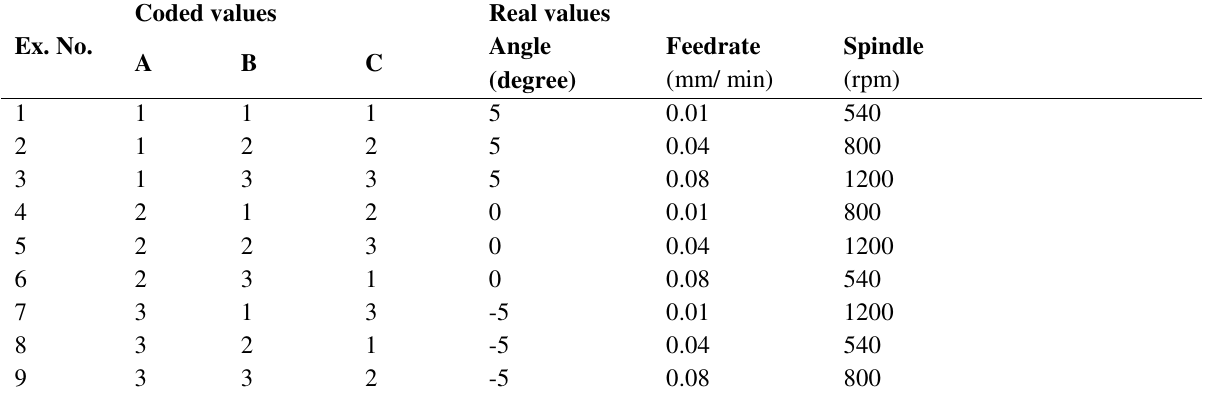
The distribution of the experiments and the